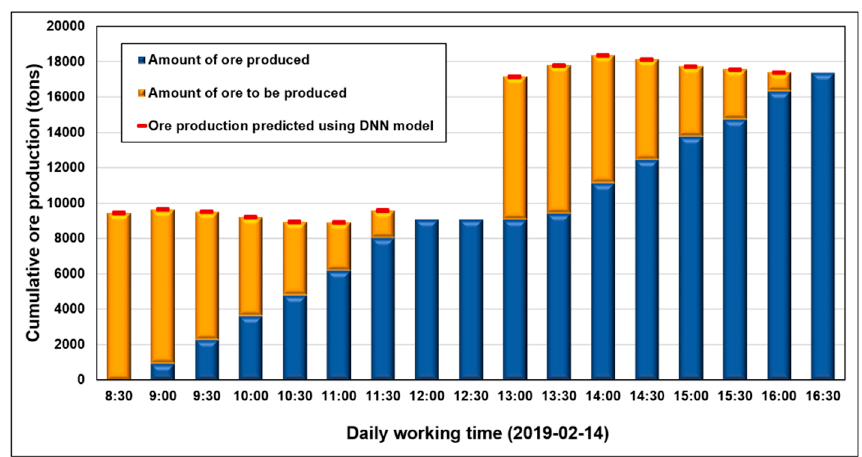
Figure 14. Ore-production predictions performed every 30 min on 14 February, 2019.